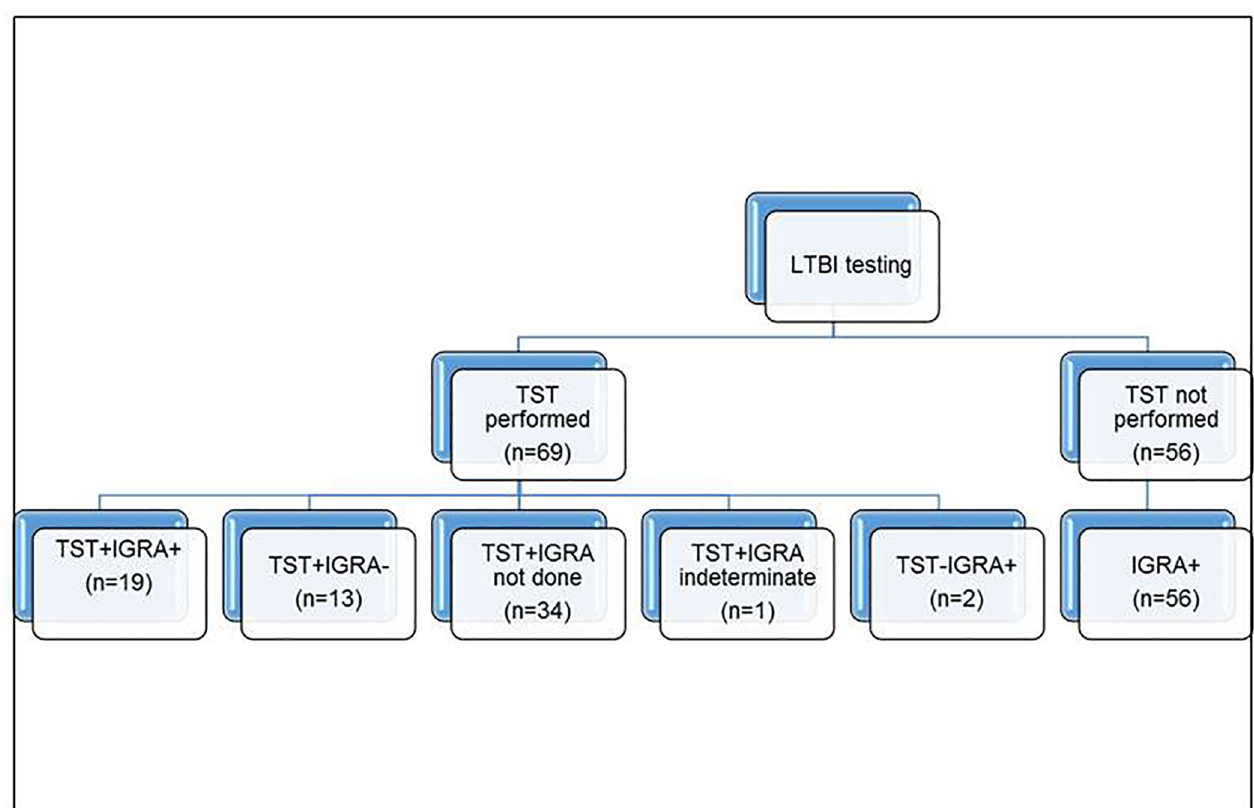
Fig 1. Showing all subjects included in the study based on whether they had a tuberculin skin test (TST) performed. Those who tested negative on TST or had no TST results available had to have a positive Interferon Gamma Release Assay (IGRA) i.e. Quantiferon-TB Gold or T-spot TB test to be included in the